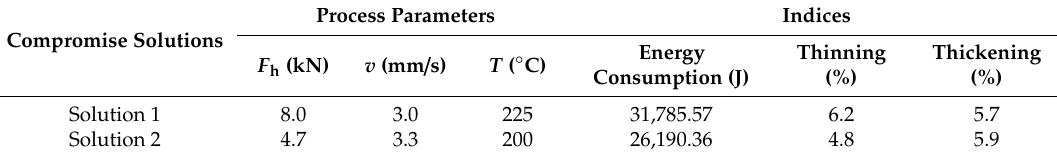
( b ) Figure 11. Thickness variation distribution demonstrated by the numerical simulation under different compromise solutions: ( a ) compromise solution 1, ( b ) compromise solution 2.